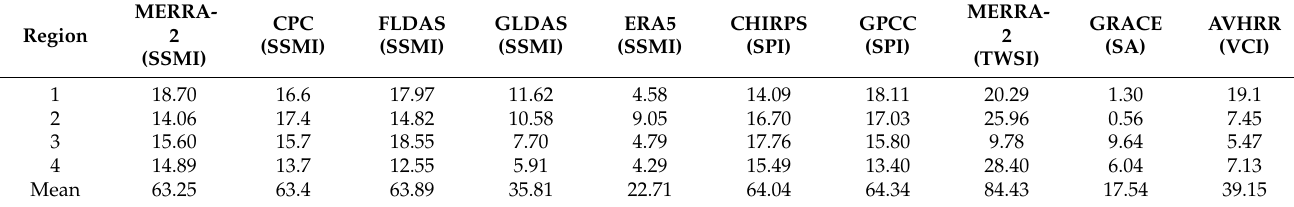
Table 4. Percentage of variance as exposed by different products for all four